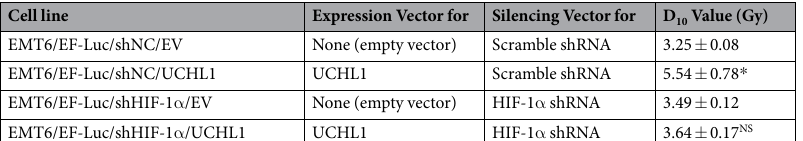
Table 1. D 10 values (The dose of radiation required to reduce the number of surviving colonies by 90%) in clonogenic survival assays of Fig. 4a and b. * P < 0.05 vs. EMT6/EF-Luc/shNC/EV group. NS: not significant vs. EMT6/EF-Luc/shHIF-1 α /EV